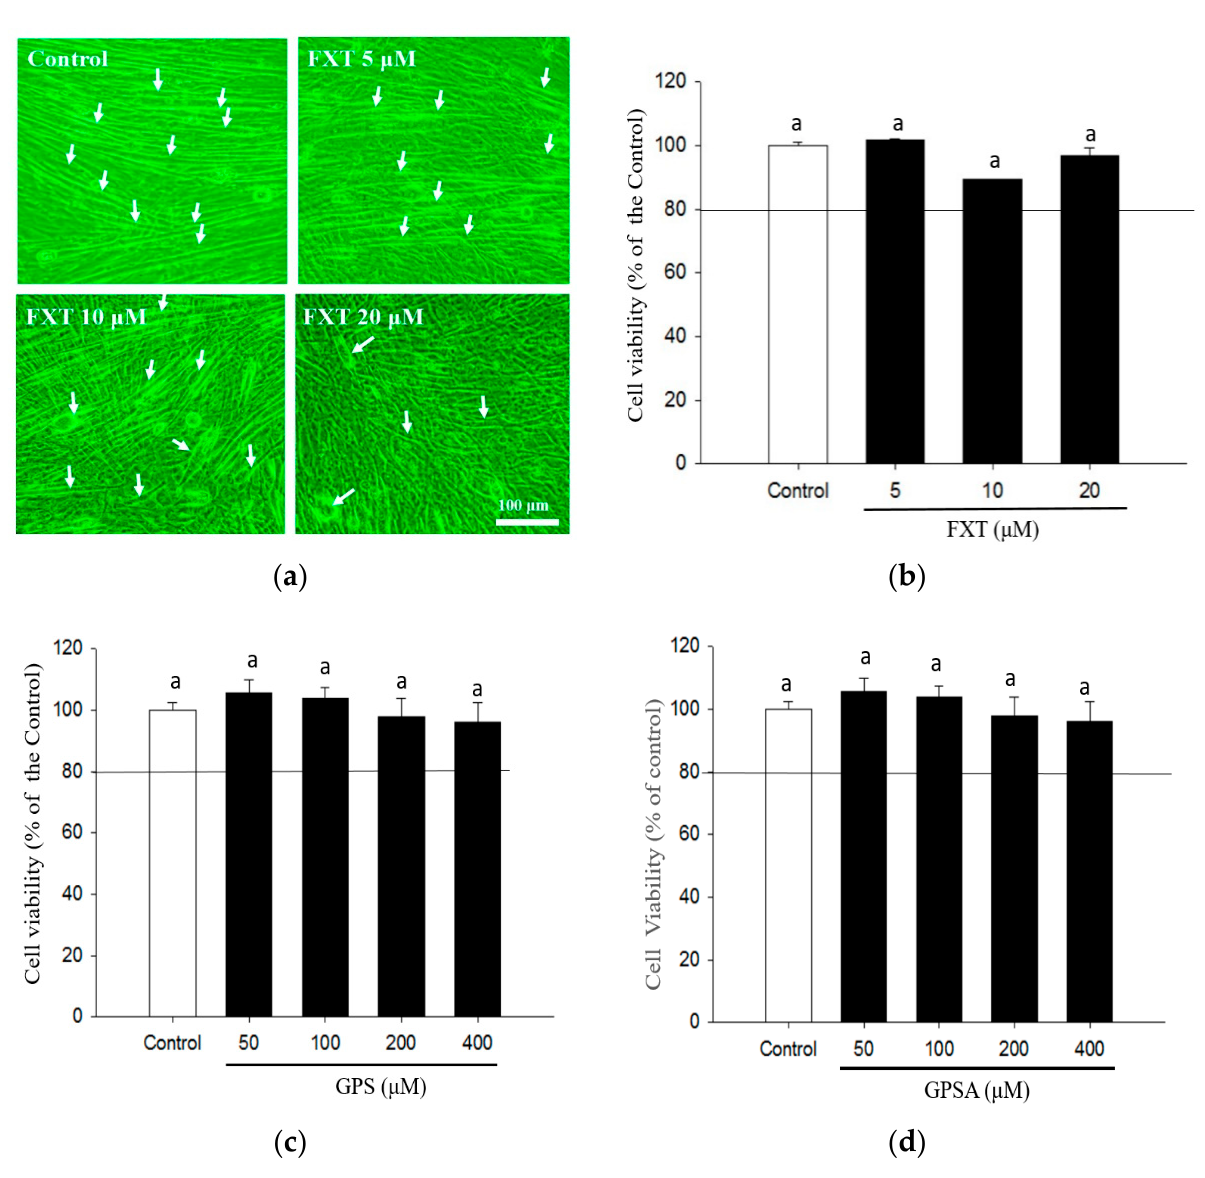
Figure 1. Myotube morphology and cell viability of C2C12 muscle cells treated or untreated with FXT, GPS, or GPSA. ( a ) C2C12 muscle cells treated with 5–20 µ M FXT for 48 h, compared with the control group without FXT treatment. Myotubes were examined with a phase-contrast light microscope (Olympus CKX41). Original magnification, × 200. Scale bar indicates 100 µ m. The arrow signs indicate the survival myotubes. Cell viability was affected by ( b ) FXT (5–20 µ M), ( c ) GPS (50–400 µ M), and ( d ) GPSA (50–400 µ M). C2C12 muscle cells were differentiated after 48 h of culture for 4 days. Data are expressed as mean ± SD ( n = 3). Different letters in lowercase indicate significance between one another as p < 0.05.